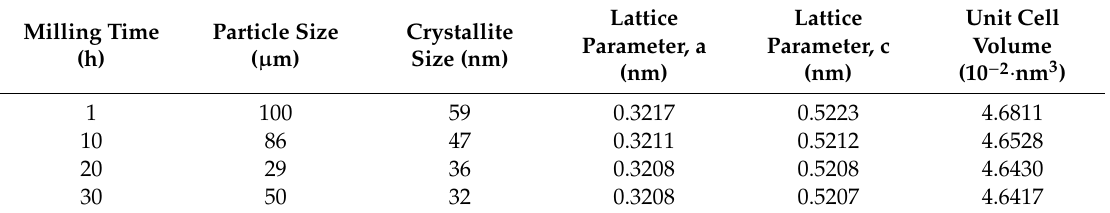
Figure 3. XRD patterns of ( a ) Mg 97 Zn 1 Y 2 alloy after milling for 1 h, 10 h, and 20 h; ( b ) pattern taken from 36° to 37° showing shifting of (101) Mg peak. Table 2. Particle size, XRD-calculated crystallite size, lattice parameters and unit cell volume of Mg, porosity, and a fraction of oxide in the MA powders after different processing time.